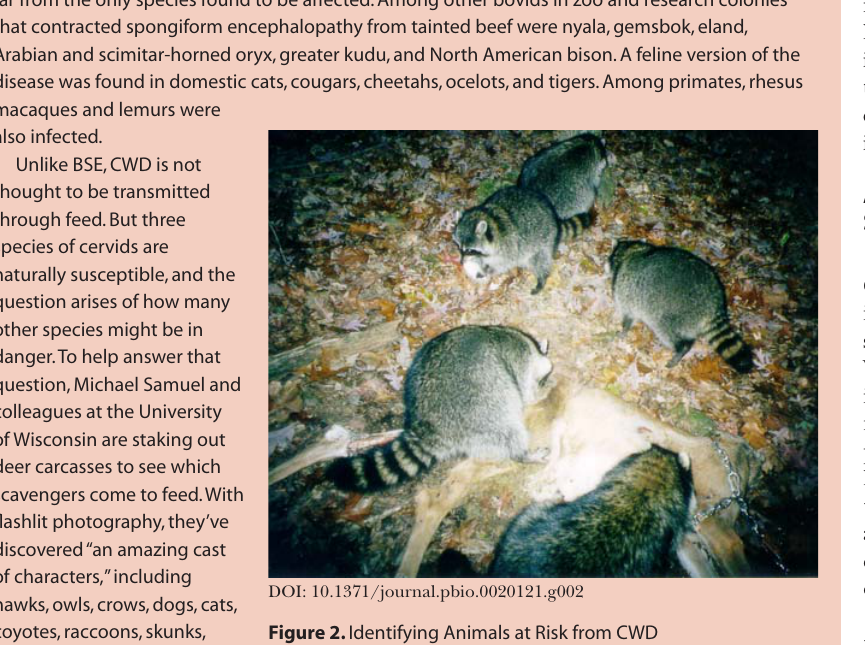
Figure 2. Identifying Animals at Risk from CWD A raccoon family feeds on a deer carcass staked out by researchers at the University of Wisconsin, in a study aimed at determining which species could be at risk of contracting CWD. (Photo courtesy of the Wisconsin Cooperative Wildlife Research Unit, University of